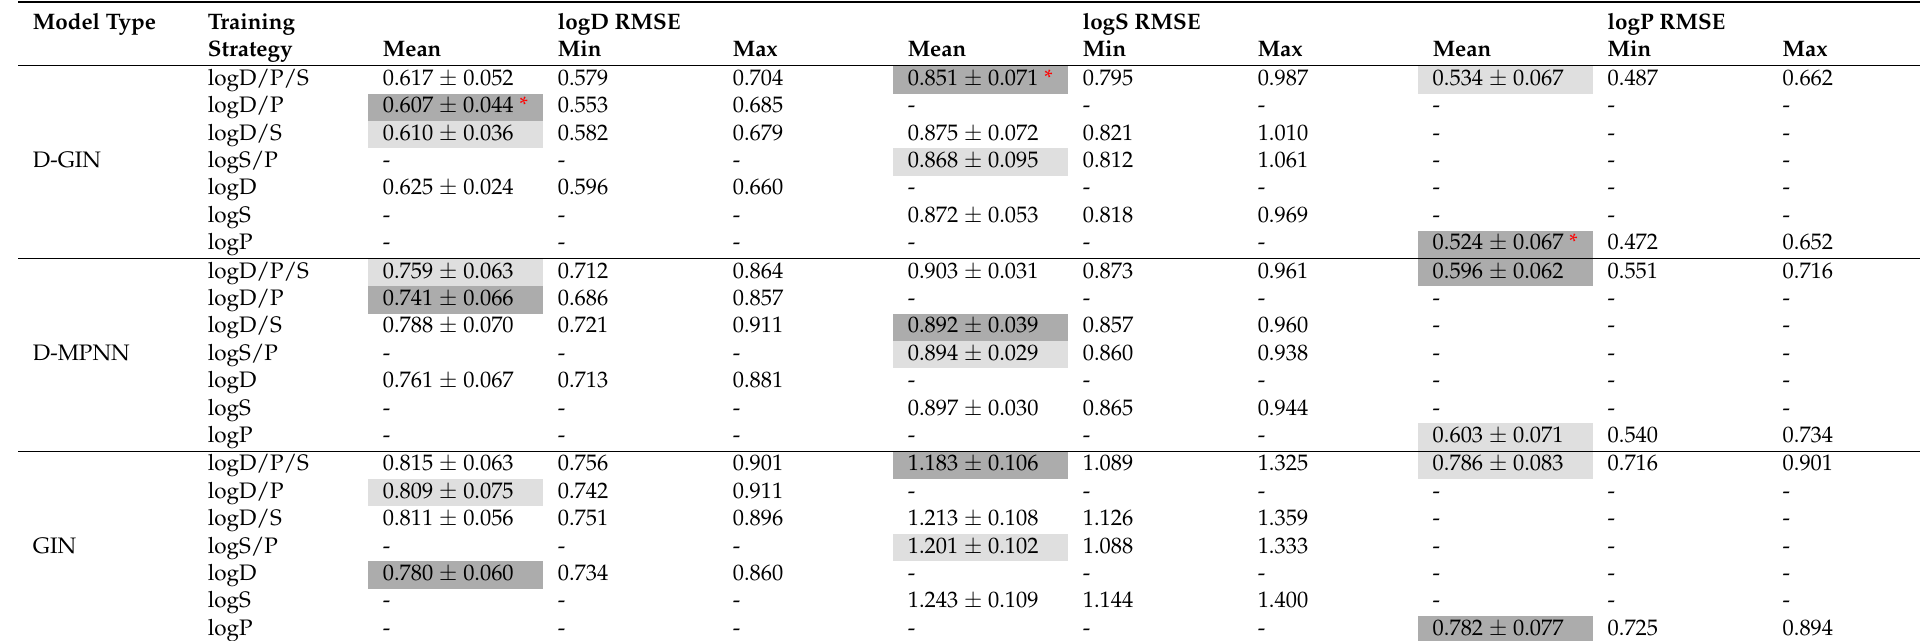
Table 5. Impact of the training strategies on the different molecular properties. Each model type is evaluated separately. For each property and model type, the mean, minimum, and maximum RMSE are shown. The dark gray boxes represent the best RMSE for the particular property and model type, the light gray the second best. The red asterisk highlights the overall best RMSE for the particular